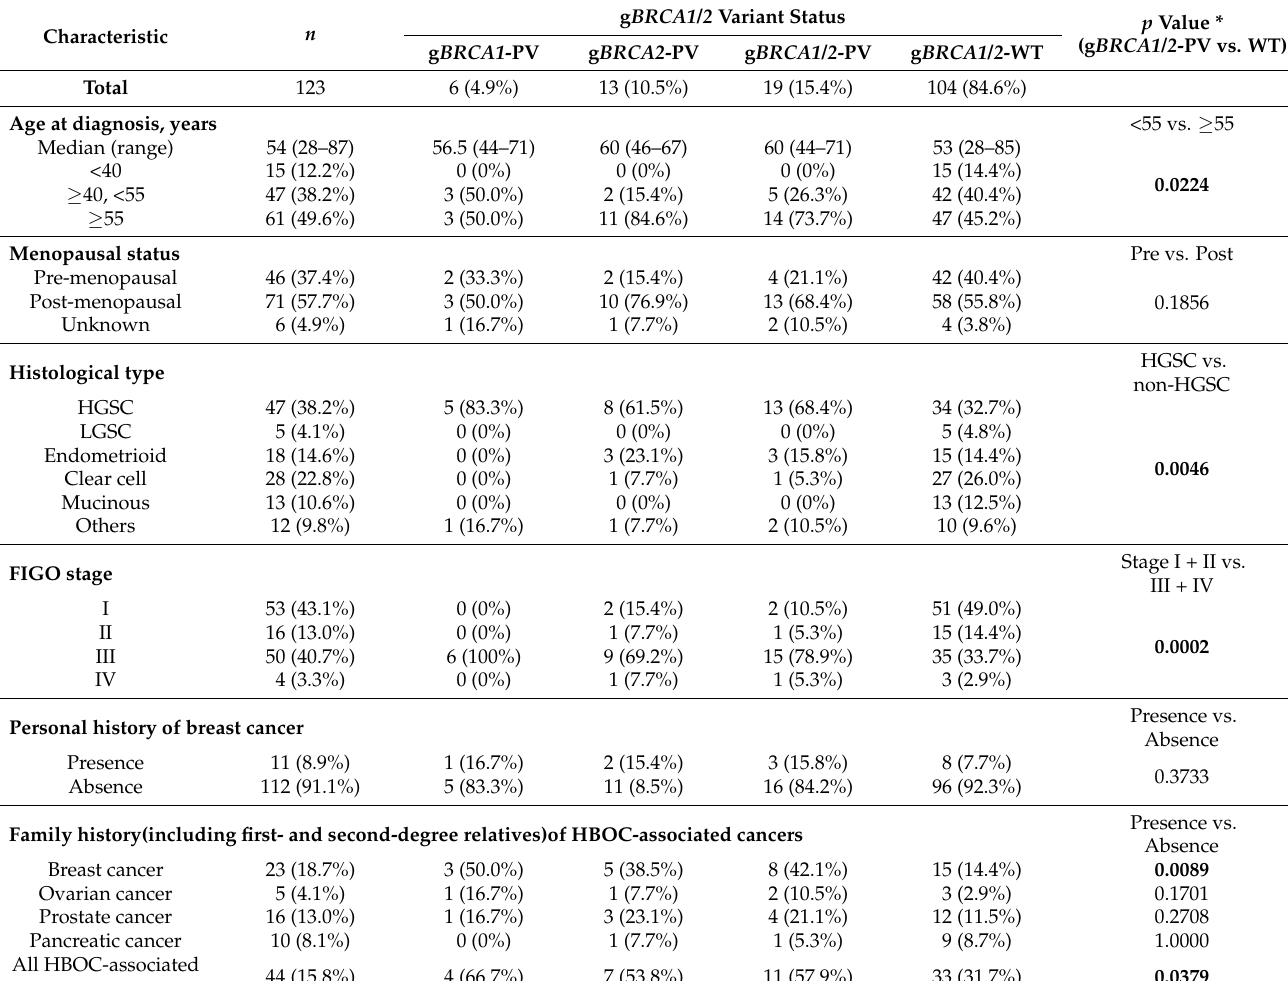
Table 1. Correlation between patient characteristics and germline variant status of BRCA1/2 in 123 patients with ovarian cancer